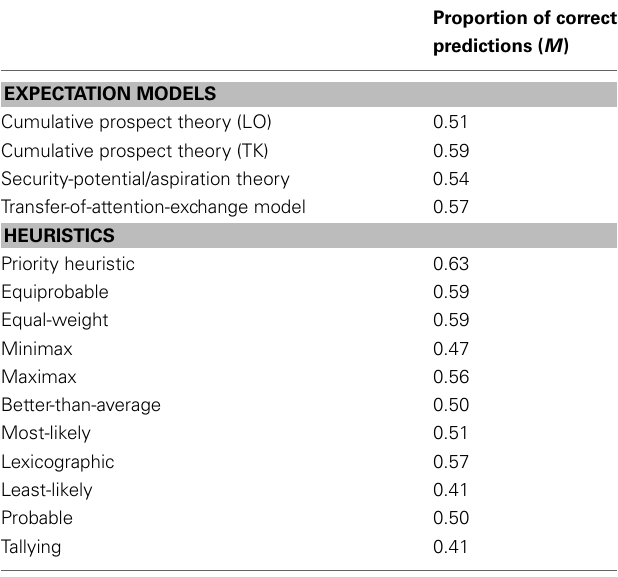
Table F1 | How well do expectation models and heuristics